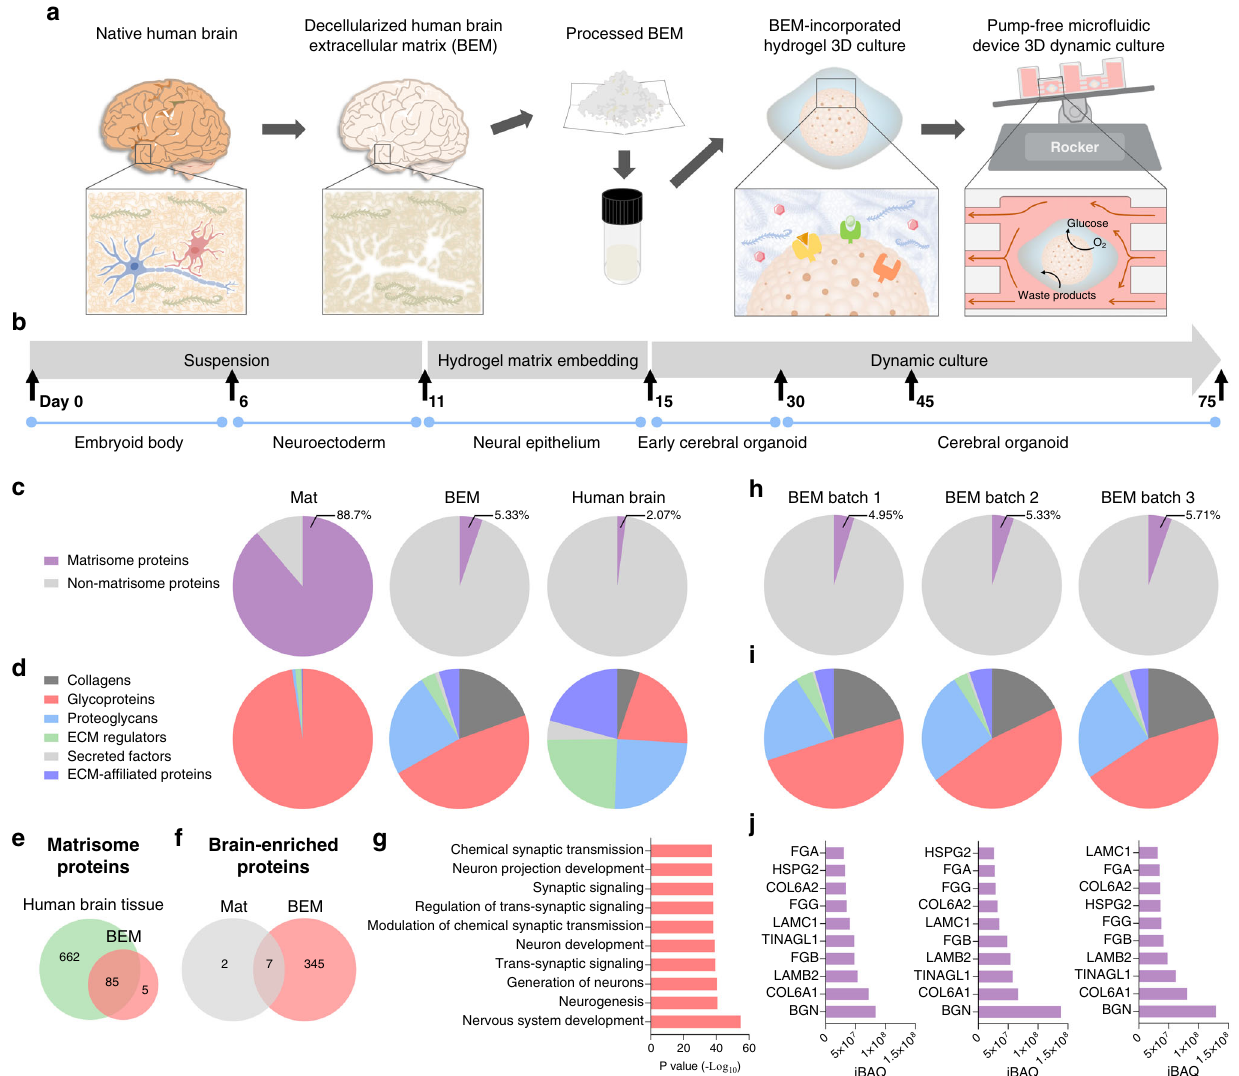
Fig. 1 Characterization of decellularized human brain-derived extracellular matrix (BEM). a Schematic illustration of the cerebral organoid culture system with a combination of 3D BEM hydrogel culture and the micro fl uidic device. b Schematic of the culture protocol for generating cerebral organoids from human induced pluripotent stem cells (iPSCs) using a brain-mimetic culture system. The developmental stage of organoids is shown at the bottom, the timeline for each developmental stage is shown in the middle, and the culture condition is shown at the top. c – j Proteomic analysis for the identi fi cation of extracellular matrix (ECM) components in human BEM. The percentages of ( c ) matrisome proteins out of total proteins, and ( d ) the subtypes of matrisome proteins identi fi ed in BEM, Matrigel (Mat), and human brain tissue ( n = 1 for Mat, n = 3 for BEM). e Total numbers of matrisome proteins detected in the human brain tissue and BEM. f The number of the brain-enriched proteins by at least 4-fold compared to other organs. g The top 10 biological process terms ordered by p value after gene ontology enrichment analysis of brain-enriched proteins exclusively present in BEM, which are not detected in Mat. The compositions of ( h ) matrisome proteins relative to total proteins and ( i ) the subtypes of matrisome proteins in three batches of BEM (biological replicates = 3). j Most abundant matrisome proteins found in each batch of BEM. Source data are provided as a Source Data fi